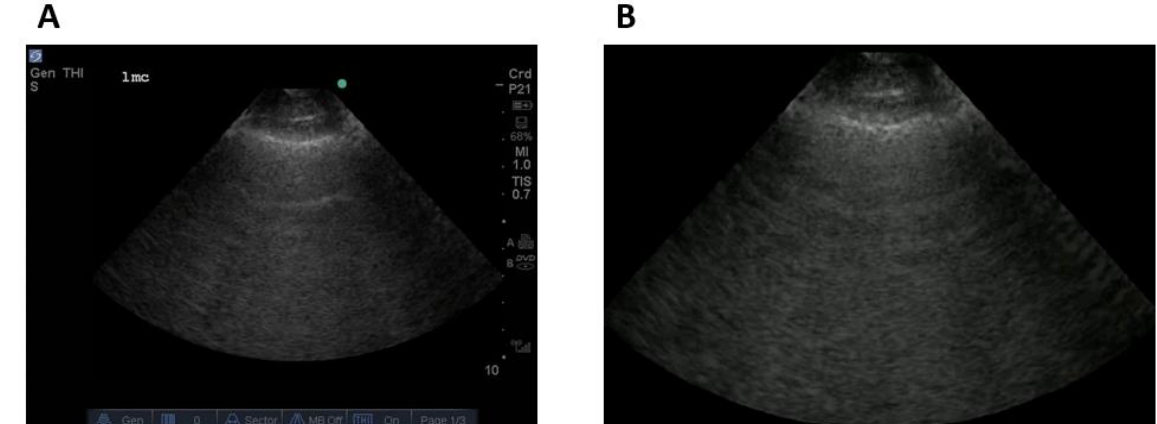
Figure 4. Masking of native ultrasound image ( A ) resulting in a frame consisting of only the ultrasound image without